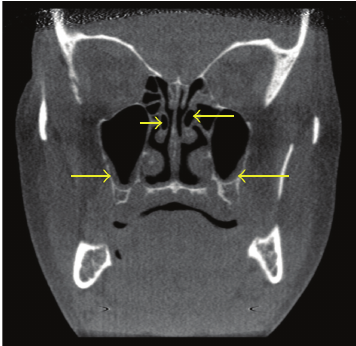
Figure 4: Coronal CT scan demonstrating right middle concha bullosa (superior arrow) and right maxillary sinusitis (inferior arrow). No nasal septal deviation is present. Note the di ff erence in size of the right middle concha compared to the left middle concha.